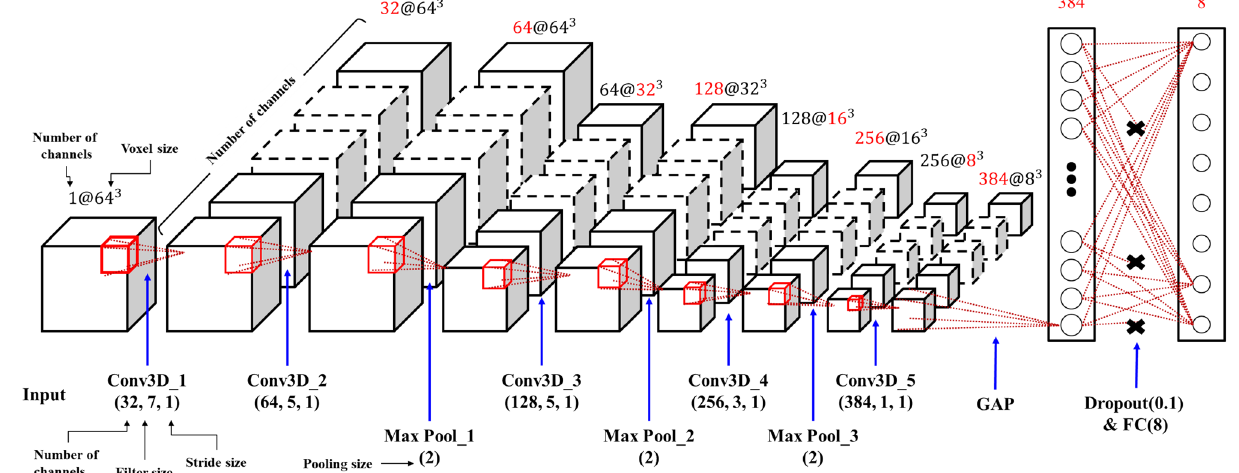
Figure 3. Network architecture for feature recognition.